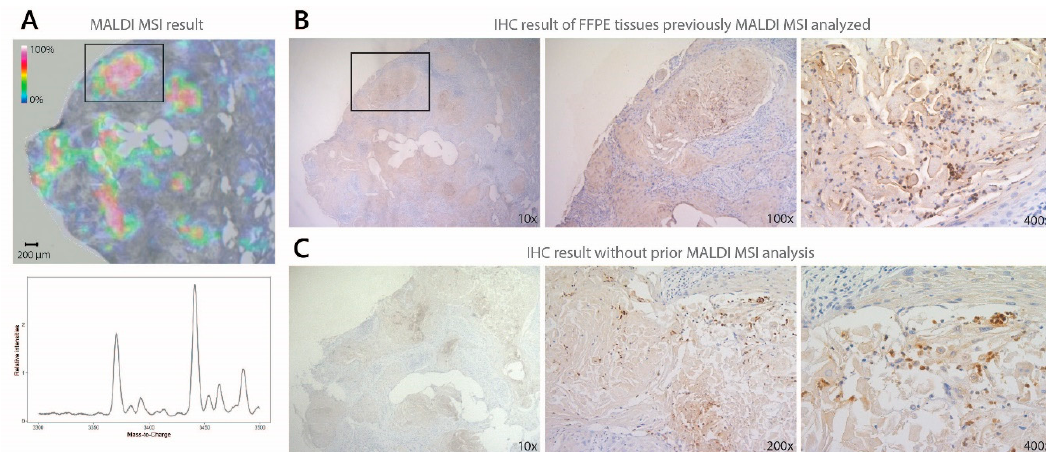
Figure 4. Comparison of defensin 1 / 3 antibody staining on FFPE tissue sections previously MALDI MSI analyzed and without prior MALDI MSI analysis. ( A ) Distribution of the three neutrophil defensins in FFPE lung tissue obtained with MALDI MSI. The mass spectrum displays the three neutrophil defensins, while the MSI image only displays the distribution of neutrophil defensin 1 ( m / z 3440.6), as neutrophil defensin 1 shows the same distribution as neutrophil defensin 2 ( m / z 3369.5) and 3 ( m / z 3484.6); ( B ) Validation of the presence of the neutrophil defensins obtained with MALDI MSI with immunohistochemical (IHC) analysis. The region indicated with the box in the MSI result was compared with the same tissue region after immunohistochemical analysis with the defensin 1 / 3 antibody; ( C ) No change in staining intensity is observed compared with the same IHC staining protocol on a consecutive FFPE tissue section with no prior MALDI MSI analysis.